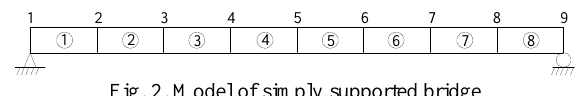
Fig. 2. Model of simply supported bridge